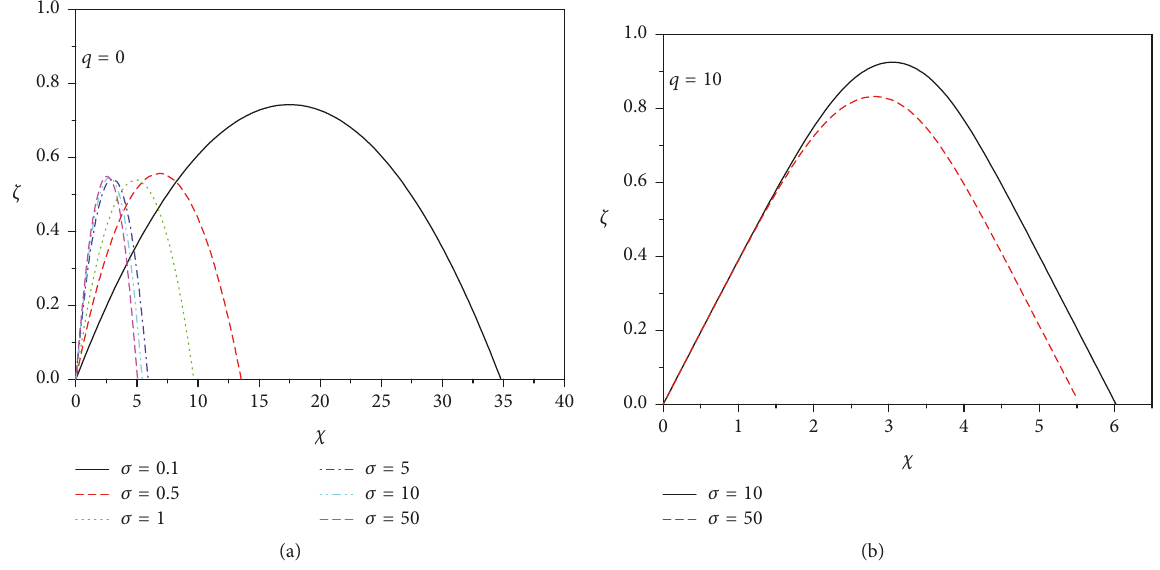
Figure 5: Trajectories of the rays for an angle of incidence 𝑖 = 63 ∘ . Two cases are shown, 𝑞 = 0 and 𝑞 = 10